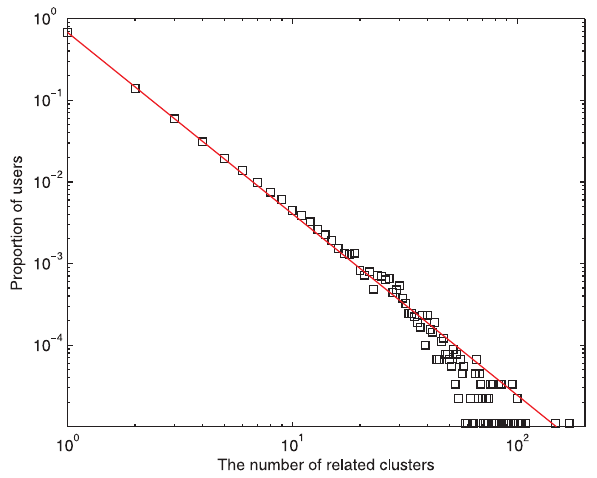
Figure 1. Distribution of the number of users’ topic interests in Tianya BBS. The double logarithmic curve shows a power-law property, with the power exponent of { 2 : 222 + 0 : 002 . Most users concentrate on less than 10 topics, and none of users have more than 200 topic interests.